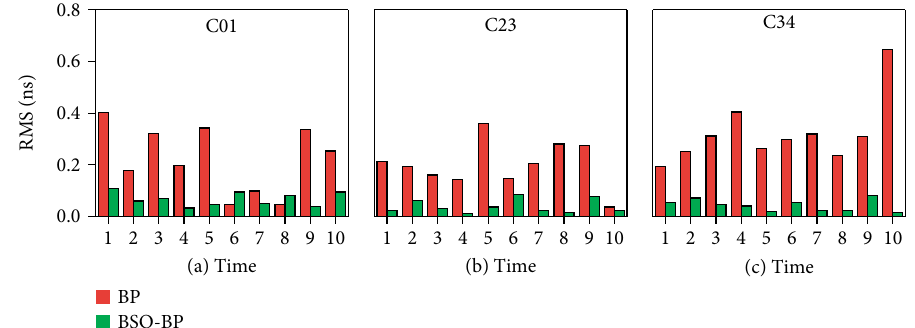
Figure 5: (a) The RMS value of 10 C01 continuous predictions. (b) The RMS value of 10 C23 continuous predictions. (c) The RMS value of 10 C34 continuous predictions. The green color represents the results predicted using the proposed BSO-BP model, and the red color represents the results predicted using the BP model.